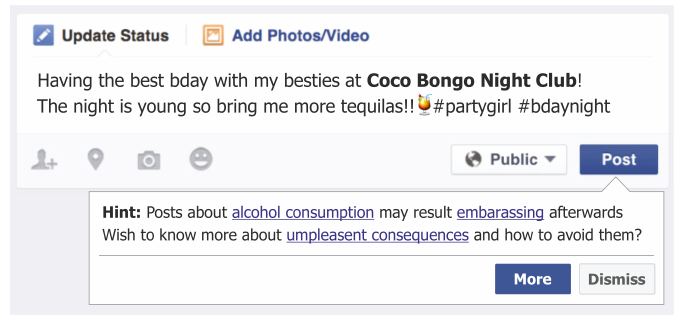
Figure 2. Envisioned